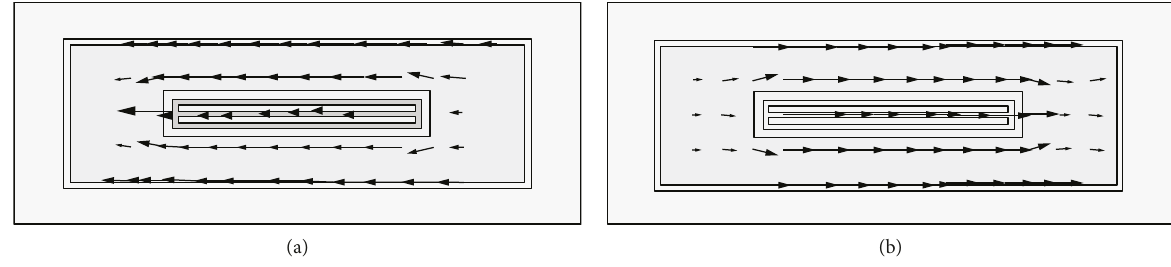
Figure 6: The surface current of the antenna at the frequency 915MHz. (a) Phase = 0 . (b) Phase = 180 degrees.